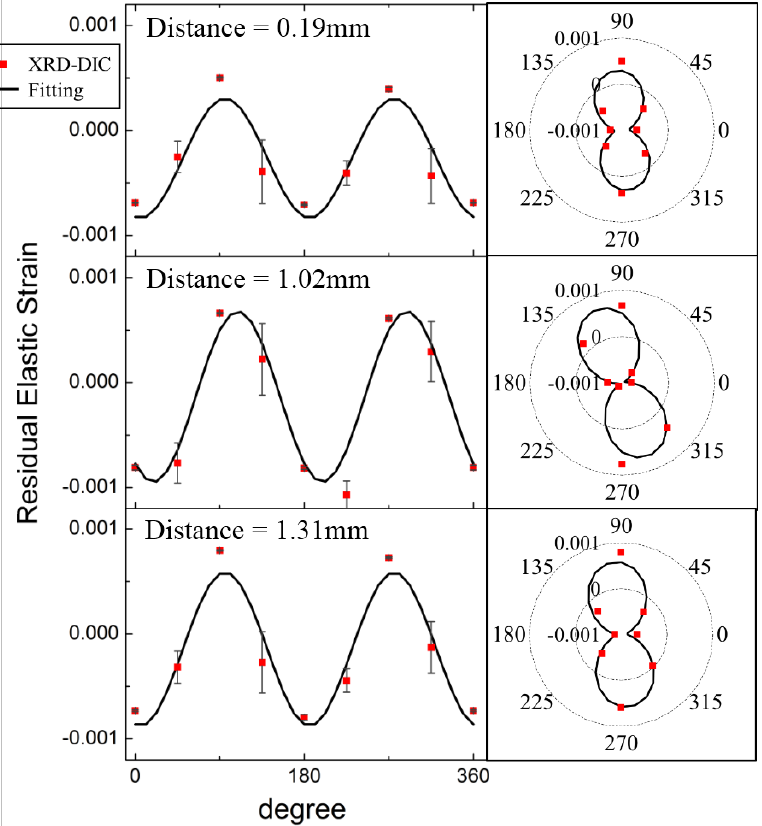
Figure 5. The azimuthal variation of residual elastic strains obtained using XRD-DIC from distance 0.19mm, 1.02mm and 1.31mm as examples, showing the results of least squares fitting along with corresponding polar plots.